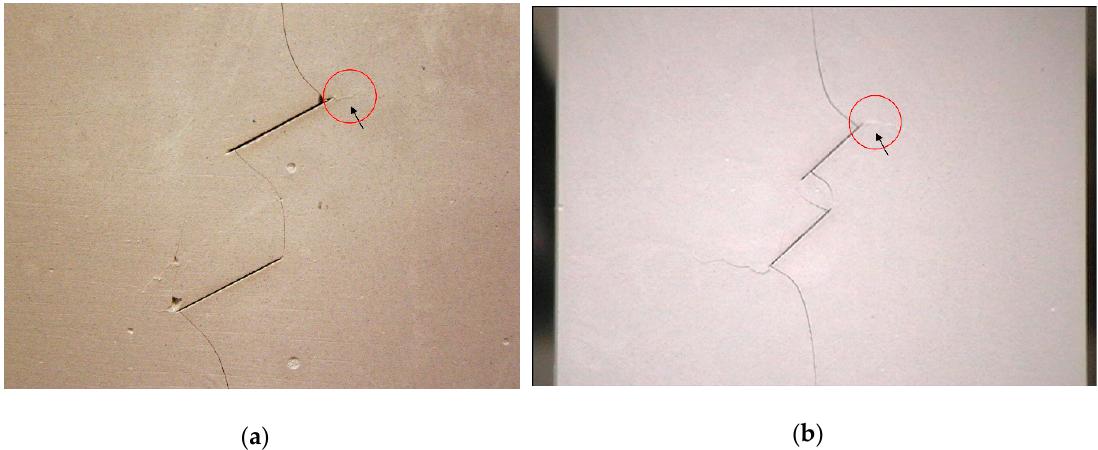
Figure 9. An example of secondary cracks ( a ) colinear secondary cracks in the 30-2a-0 geometry; ( b ) horizontal secondary cracks in the 45-a-0 geometry.